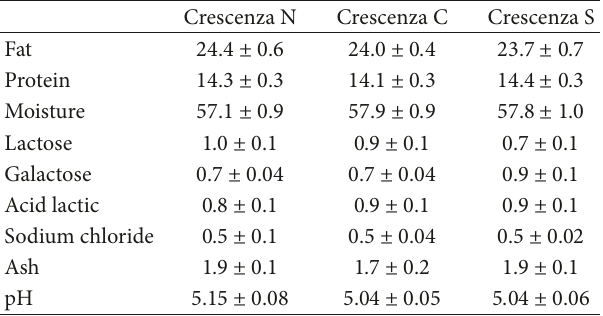
Table 1: Mean composition (% w/w) of different Crescenza types manufactured for this